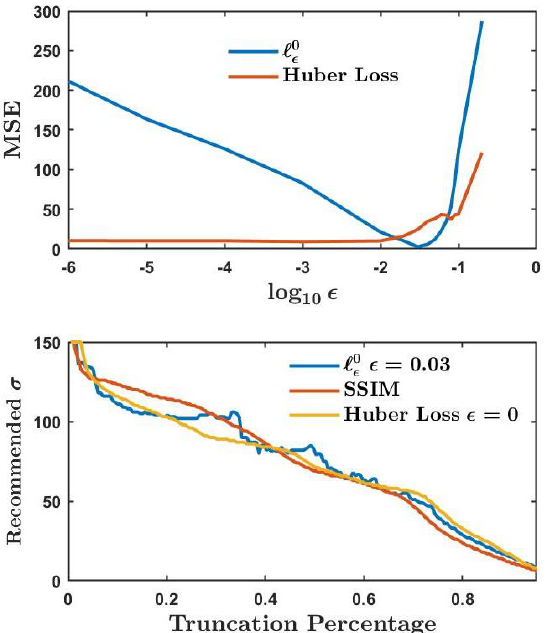
Figure 9. ( top ) Mean squared error as a function of log SSIM and Huber loss (red). Best values of (cid:101) are identified by the minima. ( bottom ) Best σ for the Gaussian filter as a function of truncation percentage, as recommended by the three metrics (using (cid:101) as identified